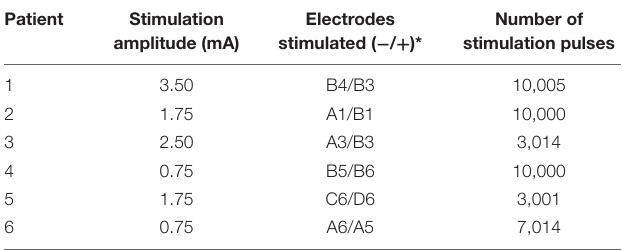
TABLE 1 | Stimulation parameters applied in the cohort.